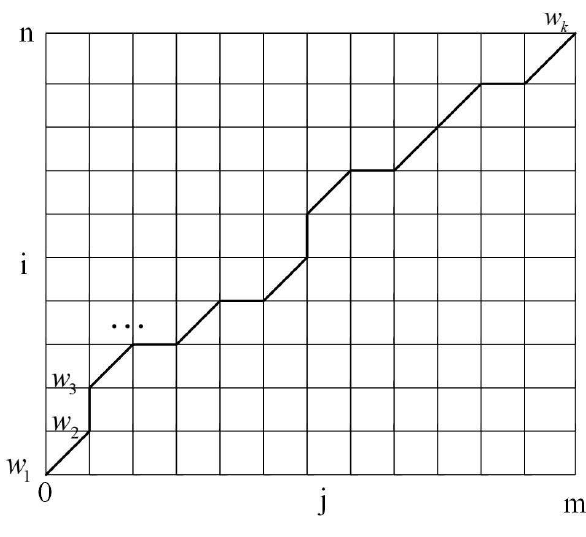
Figure 2. Optimal Warping Path based on